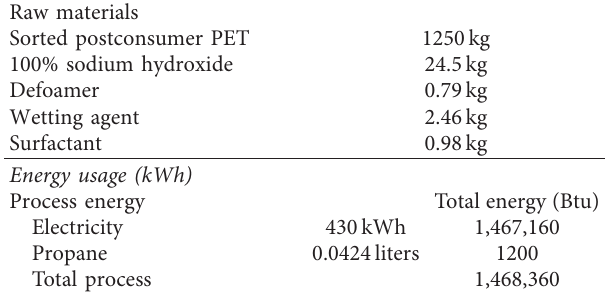
Table 6: Data for the processing of 1 ton of the postconsumer recycled PET flake.